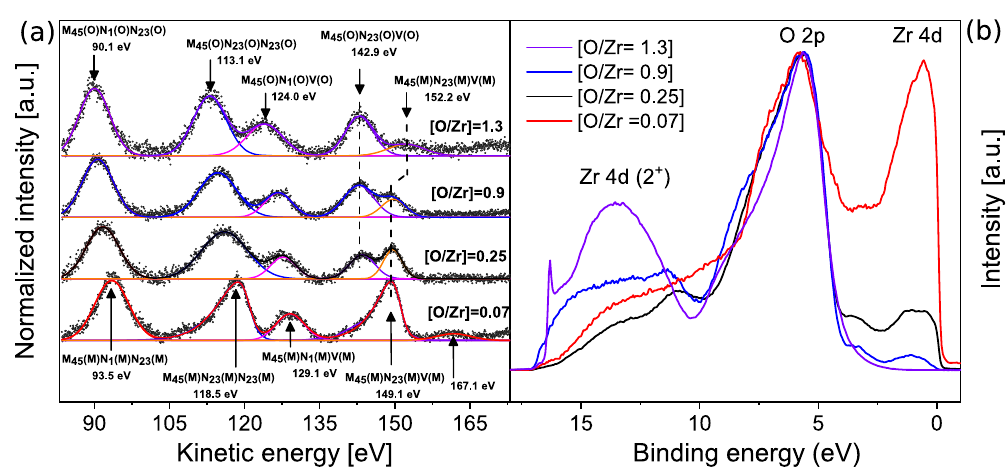
Figure 2. ( a ) As measured Auger spectra for the indicated O ratios with arbitrary vertical shift where the Zr inserted arrows indicate the KE of the Auger transitions. The colored lines stand for the different components. The open circles are the spectrum data points after background subtraction. The solid lines behind the open circles represent the sum of the different components. ( b ) Normalized UPS spectra for the corresponding Auger spectra using helium I